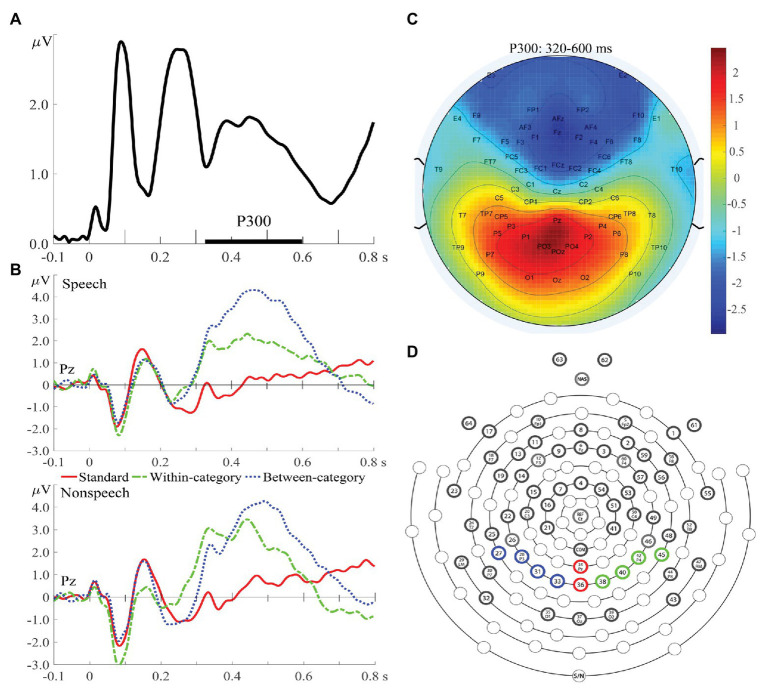
(A) Global field power averaged across all experimental conditions and across both groups of subjects. (B) Event-related potential (ERP) waves averaged from all subjects for speech (upper) and nonspeech (lower) contexts at Pz. (C) Topographic distribution map of P300 amplitudes (320–600 ms) averaged from standards and deviants. (D) A schematic view of the electrode array (64-channel HydroCel GSN), with four electrodes shaded with blue circles representing the region on the left hemisphere for the P300 component, two red electrodes in the midline, and four green electrodes on the right hemisphere.